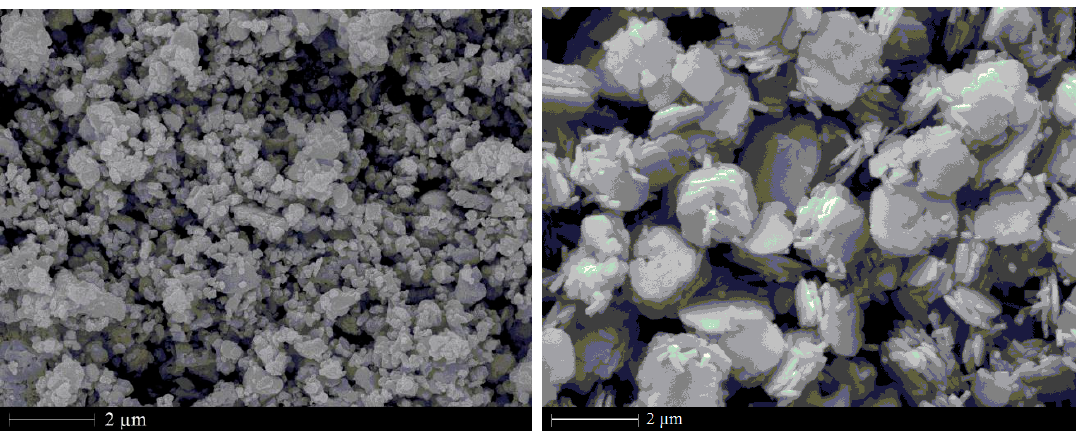
Figure 1. SEM images of the nanoscale particles (left panel) and micrometer-scaled multilayers (right panel) of BiFeO 3 .